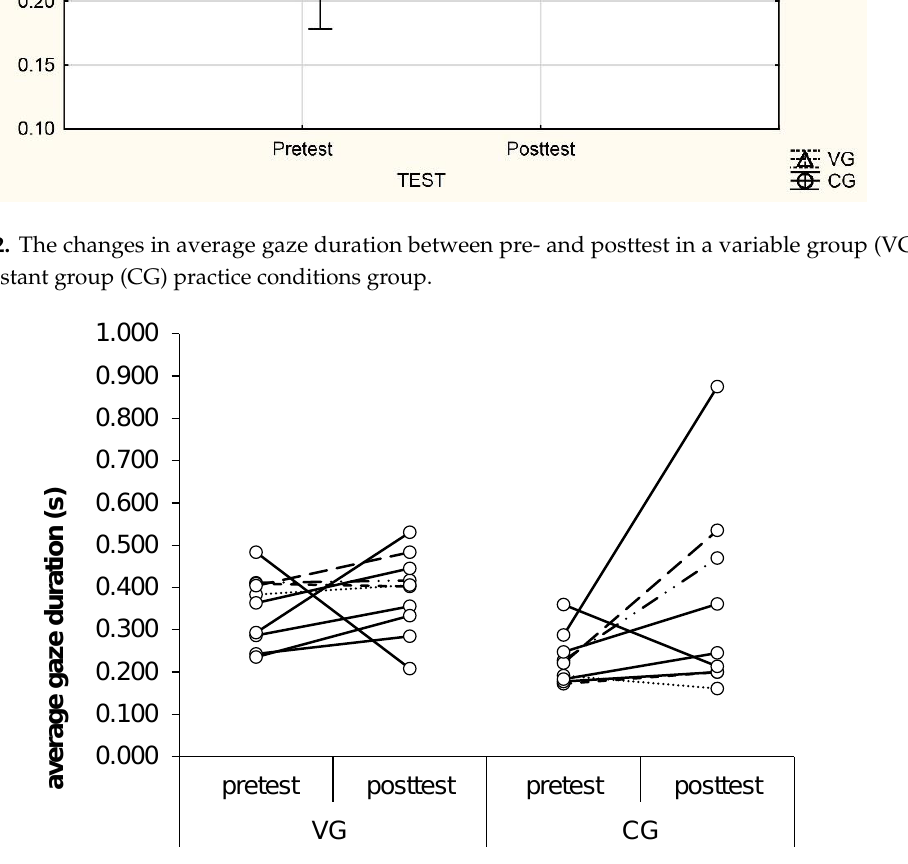
Figure 3. The average gaze duration in both groups in the pre- and posttest for each participant. Lines connect corresponding values for each participant.